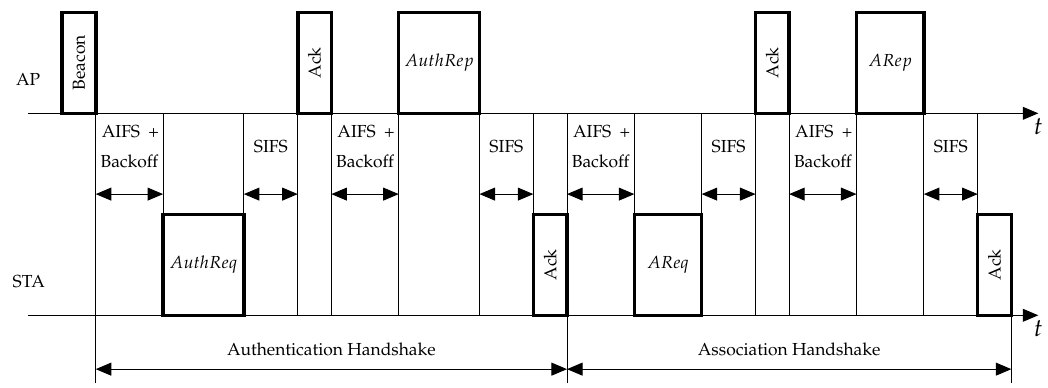
Figure 1. An example of link set-up